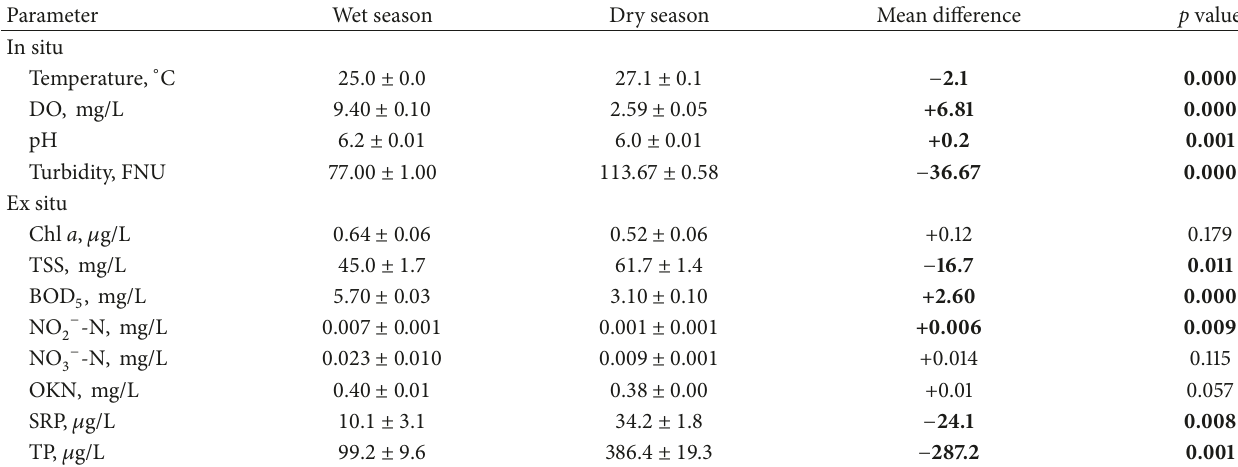
Table 5: Summary of the mean and standard deviation of the in situ and ex situ water quality parameters in the downstream river of the Bakun Dam (Station 6) and the mean difference of the parameters between the wet and dry seasons ( 𝑁 = 3 ).